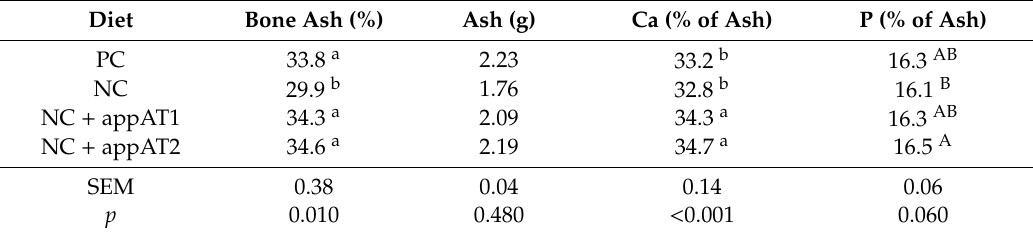
Table 6. Metacarpal bone characteristics of piglets fed the positive control (PC), negative control (NC), and NC diets supplemented with phytase (appAT1 or appAT2; n = 12). Diet Bone Ash (%) Ash (g) Ca (% of